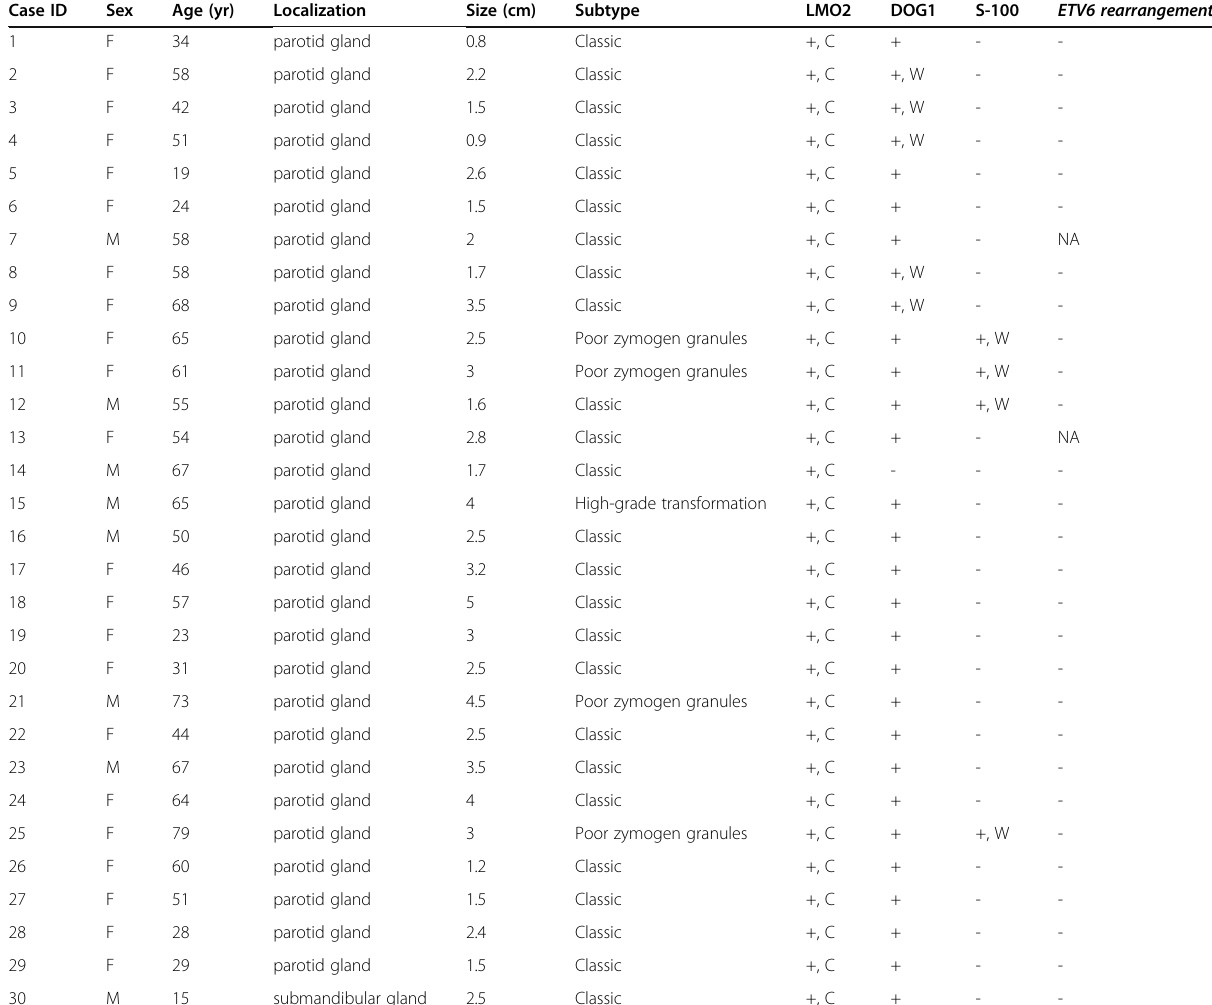
Table 1 Clinical and pathological features of ACCs of salivary gland Case ID